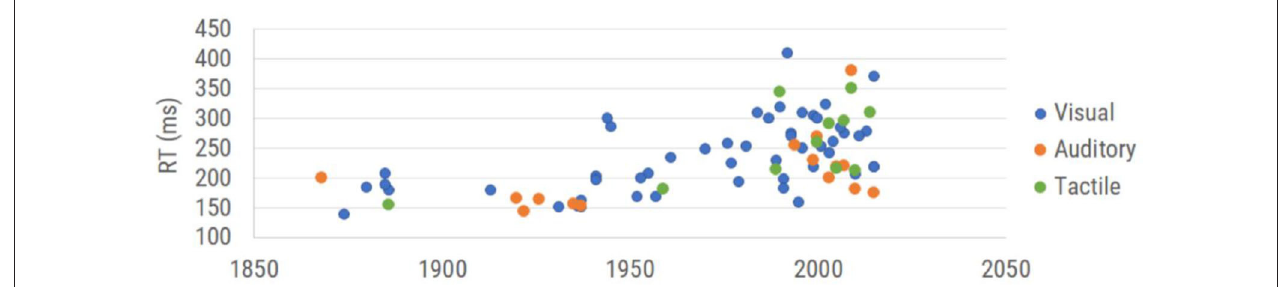
FIGURE 1 | Results of reaction time testing reported in the literature. Reaction time values are categorized by modality of measurement (visual reaction time, auditory reaction time, and tactile reaction time) and plotted in the corresponding year collected. See Table 1 (see Appendix A: Supplementary Tables ) for complete references used to obtain each data